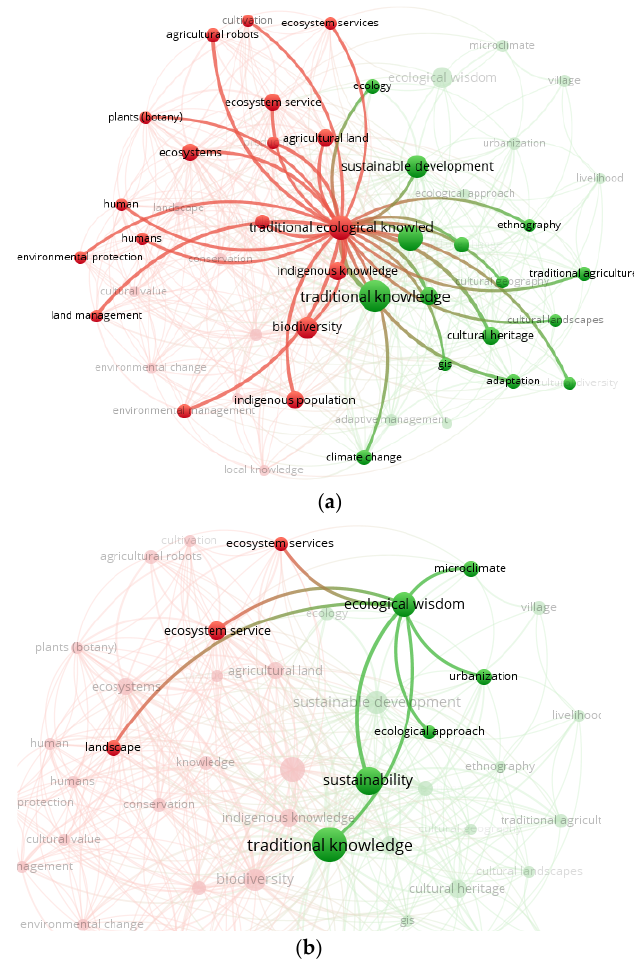
Figure 3. TEK ( a ) and EW ( b ) network in primary studies.